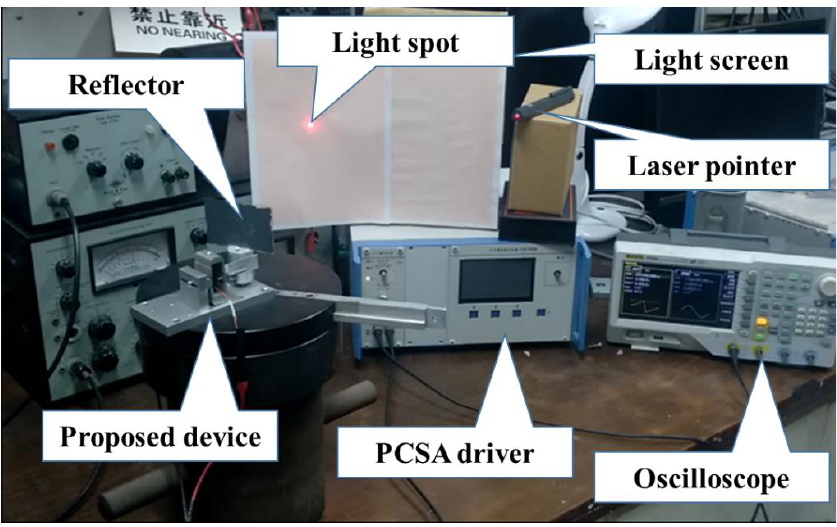
Figure 8. Laser scanning test system.